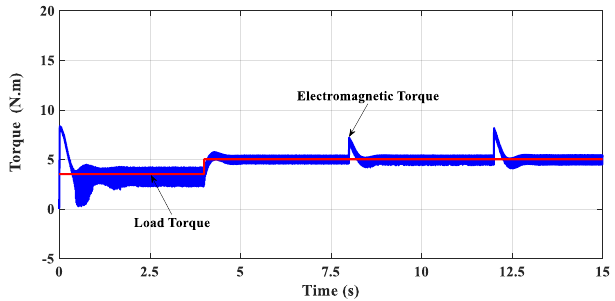
Figure 8. Electromagnetic torque response and the load torque.